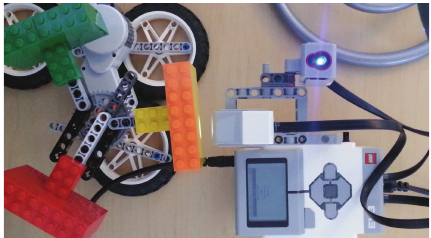
Figure 6: Picture of the EV3 brick Lego Mindstorm and the rotative color blocks setup. Thecolor sensorpoints totheblocks and thelight sensor points